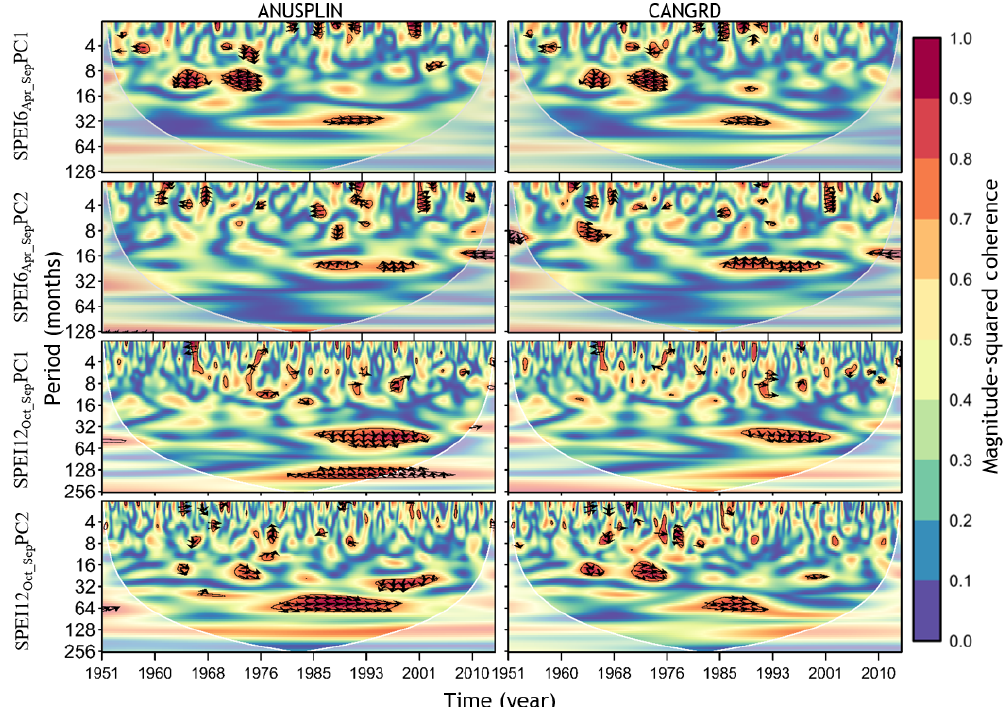
Figure 9. Squared wavelet coherence between the MEI and the temporal patterns of drought (SPEI6 Apr − Sep and SPEI12 Oct − Sep ). Phase arrows pointing right indicate signals are in phase, whereas left-pointing arrows indicate an antiphase relationship. Arrows deviating from the horizontal are indicative of lead–lag relationships between the two signals. The black contour designates the 95% confidence level against red noise, and the cone of influence (COI), where edge effects might distort the picture, is shown as a lighter grey